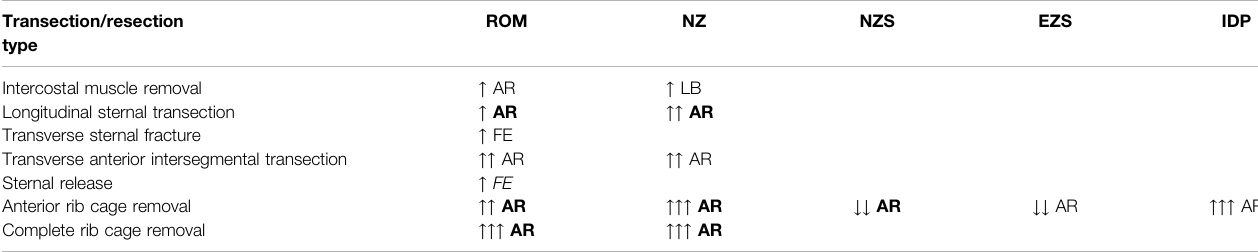
TABLE2| Summaryofquasi-staticandintradiscalpressureoutcomeparameterspresentedinthisreview.Theboxcontentsre fl ectthetrendandthepredominantlyaffected motion plane. Transection/resection